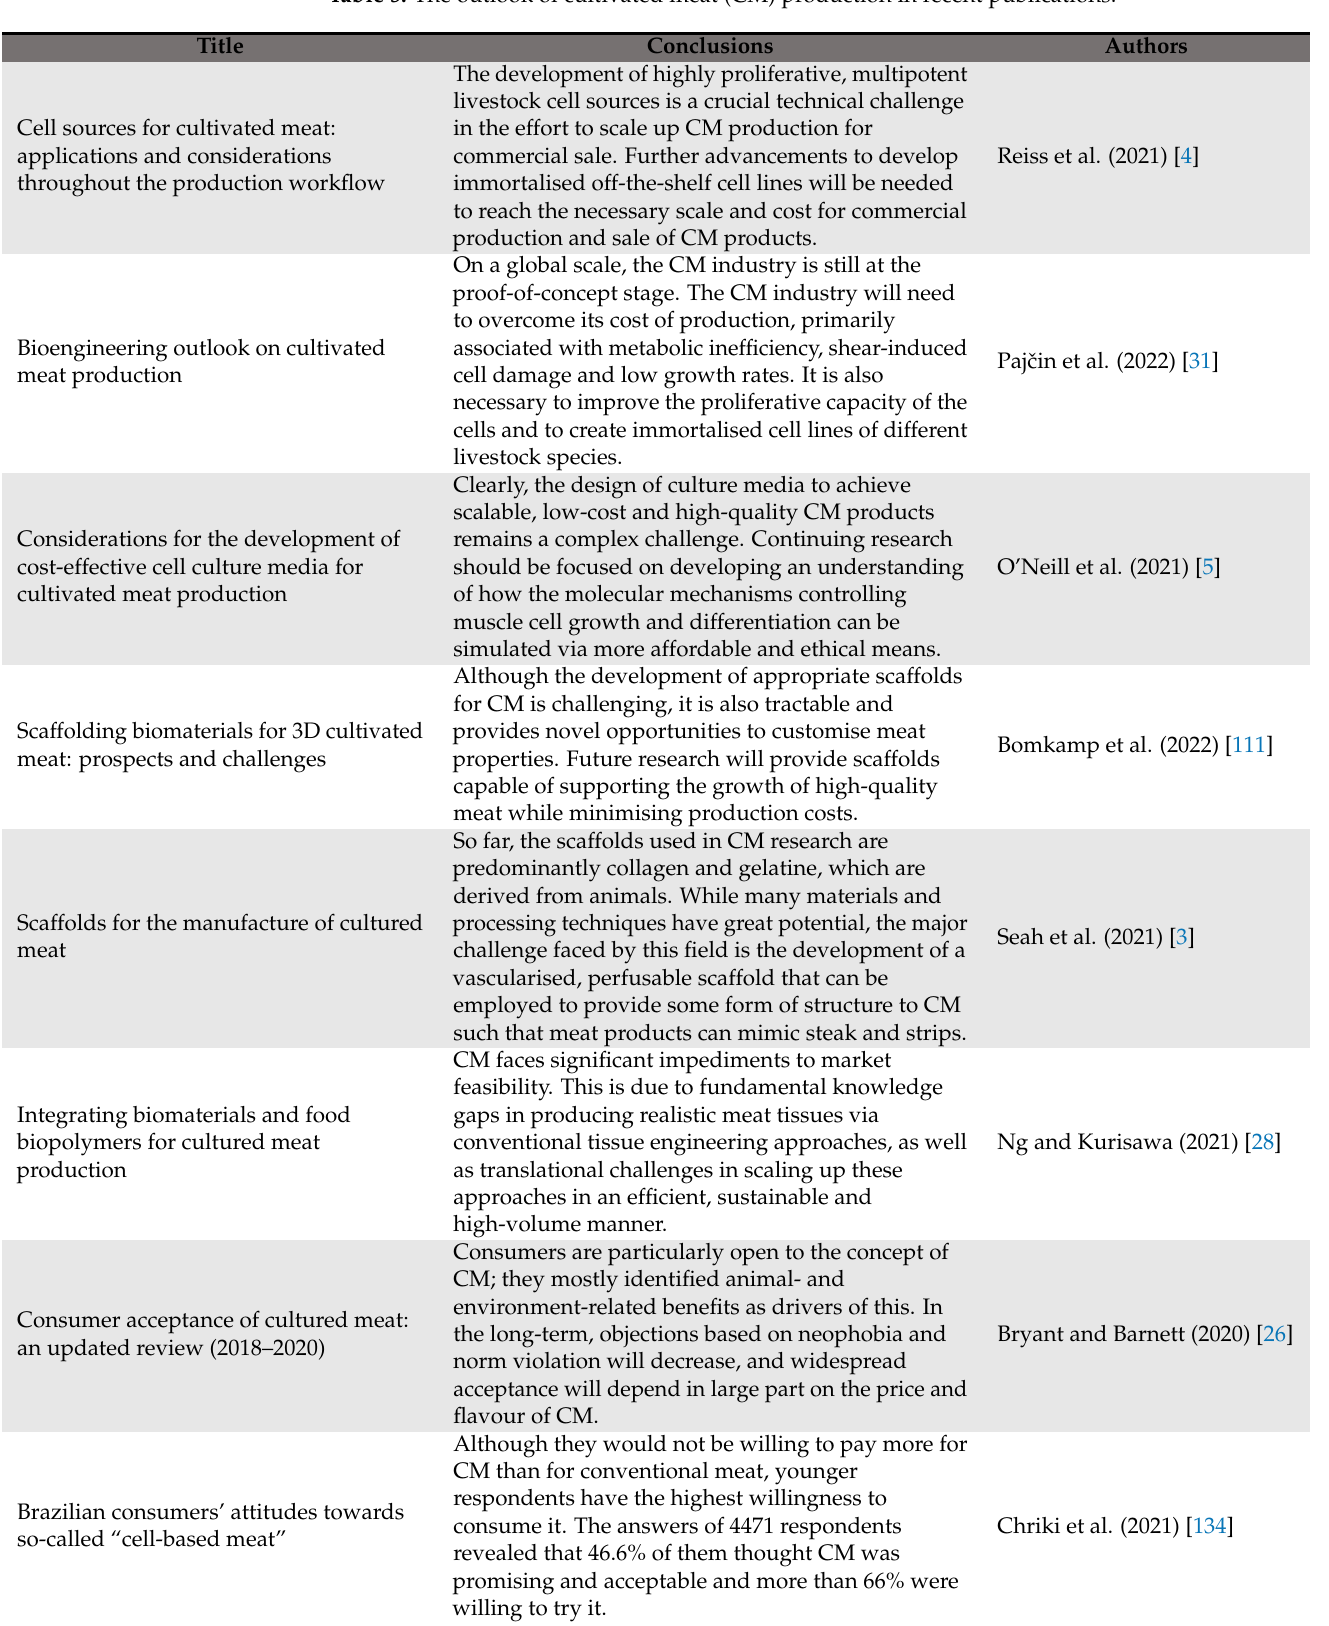
Table 5. The outlook of cultivated meat (CM) production in recent